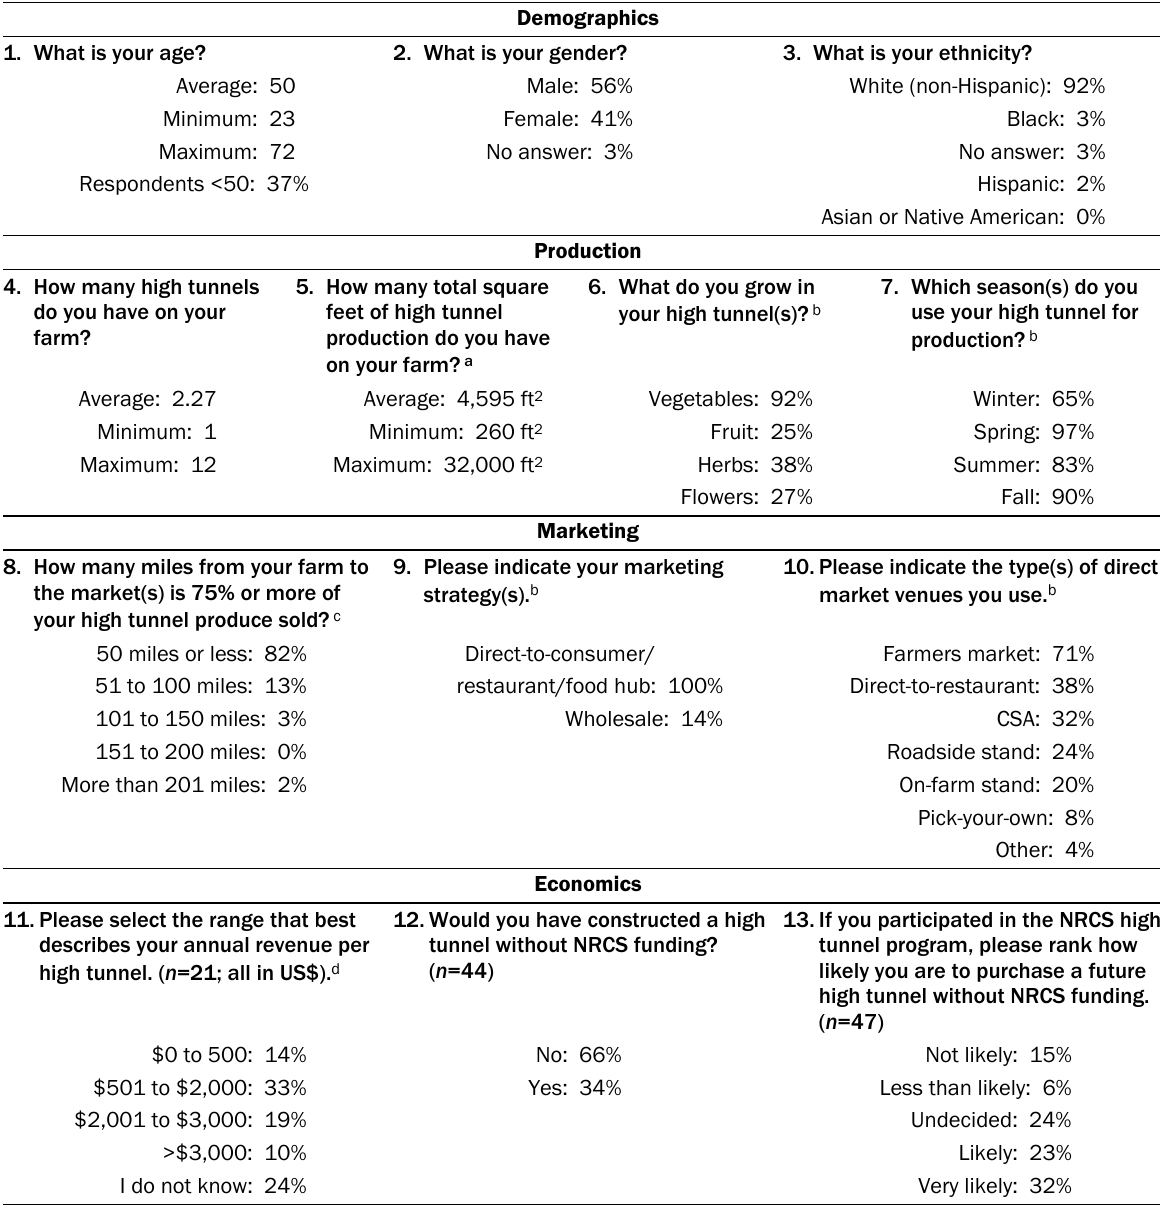
Table 2. Virginia High Tunnel Growers Survey ( n =65, except where noted)